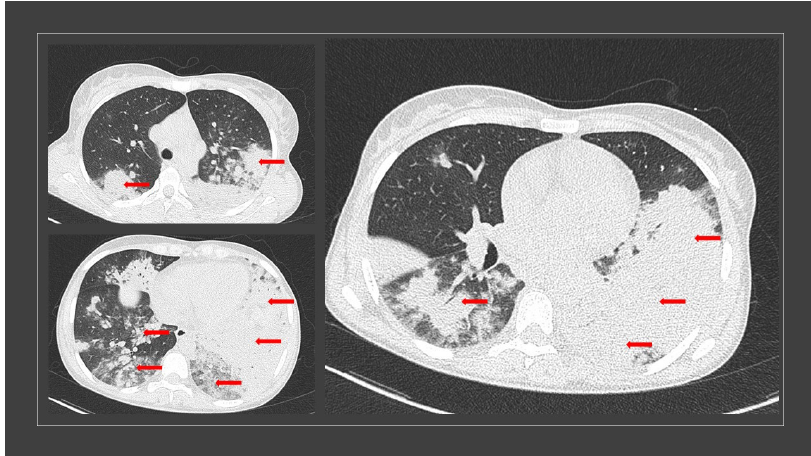
Figure 1. Chest CT-scan showing bilateral ground glass opacities with crazy paving, indicating severe CVOID-19 disease. Red arrows pointing to the extent of involvement.